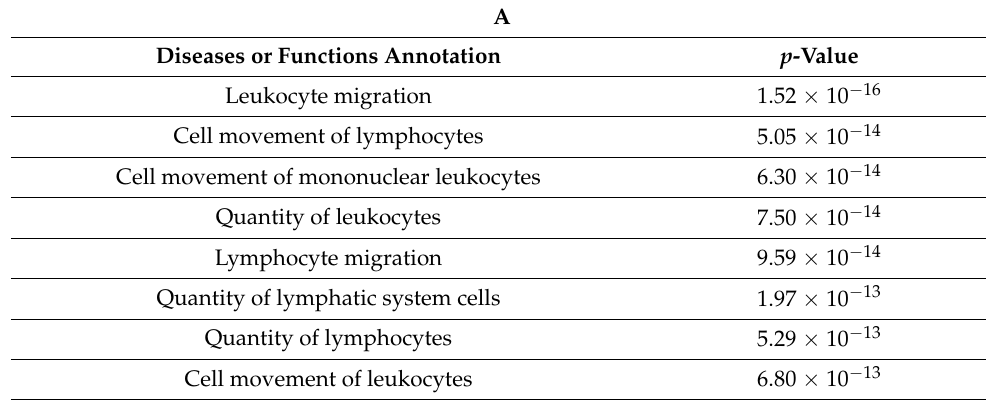
Table 2. Diseases or Functions Annotation from IPA Core Analysis on given gene datasets. The top 10 most significant annotations are